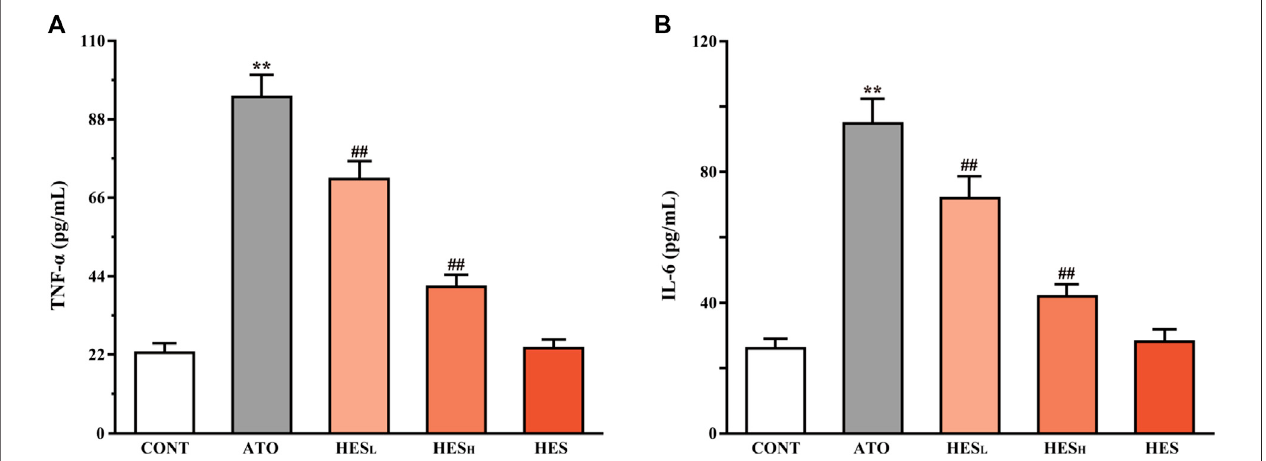
FIGURE 6 | Changes in TNF- α (A) and IL-6 (B) between the ATO group and HES treatment groups. Results are expressed as mean ± SD ( n (cid:1) 6). ** p < 0.01, compared to CONT group, ## p < 0.01, compared to ATO group.